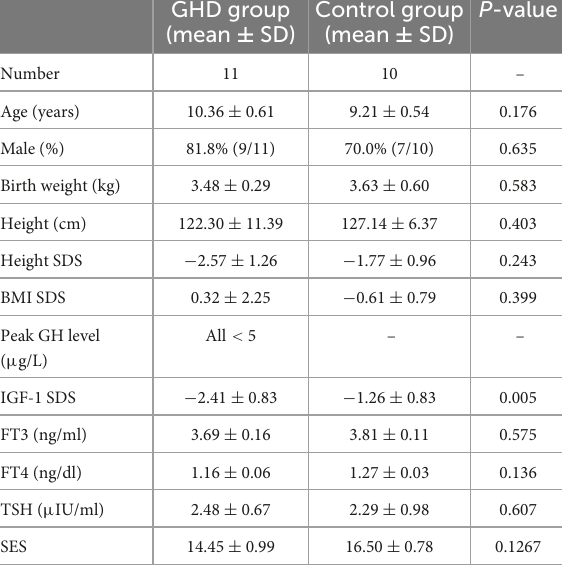
TABLE 1 Clinical and biochemical characteristics in two groups.